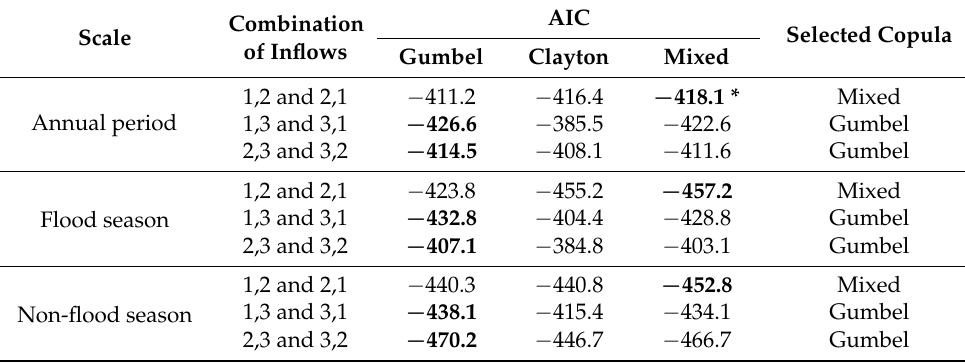
Table 6. The AIC values and selected copula functions between each two inflows. Scale